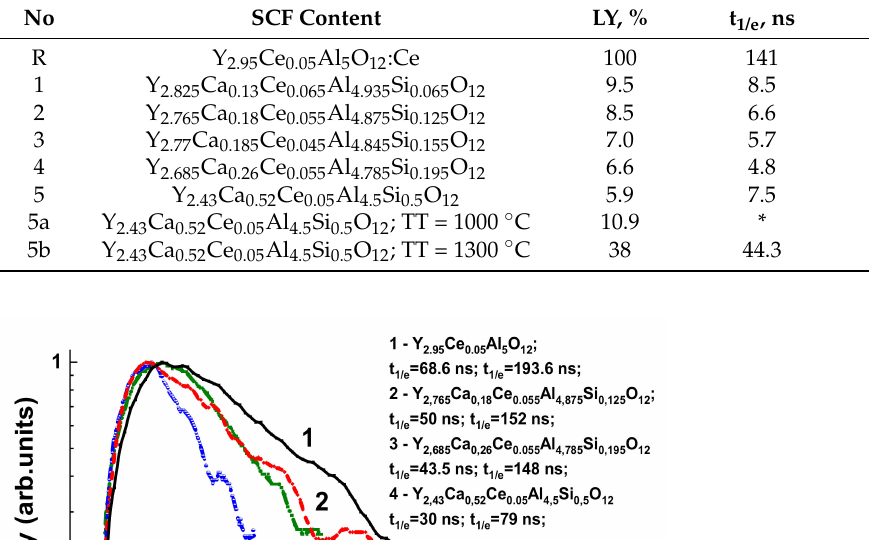
Table 3. Scintillation LY and t 1/e , t 1/20 decay times of Y 3 − x Ca x Al 5 − y Si y O 12 :Ce SCFs with different Ca and Si content under excitation by particles of 239 Pu (5.15 MeV) in comparison with YAG: Ce standard sample with an LY of 2.6 photons/keV. *—not measured.